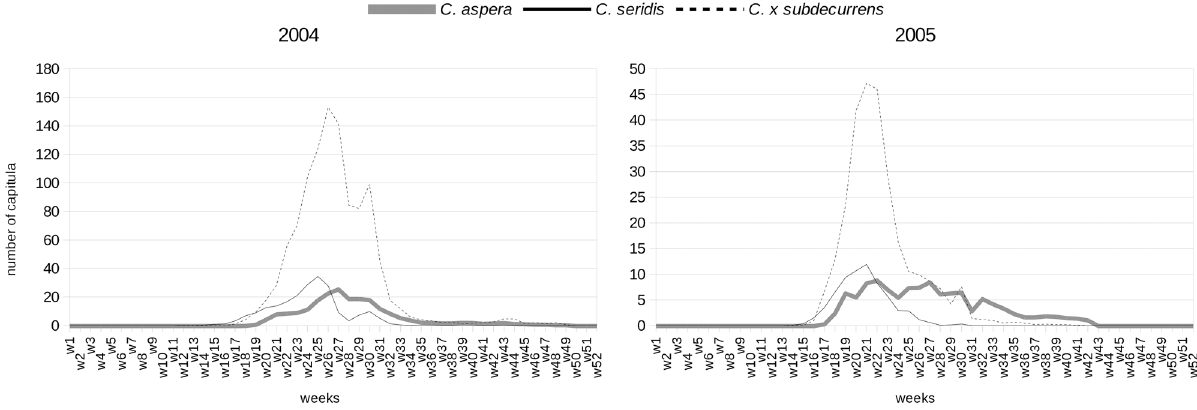
Fig 1. Flowering phenology of the diploid Centaurea aspera , the tetraploid C . seridis , and the triploid hybrid C . × subdecurrens . w1-w52: weeks of field observations; w1: start at January 5th-11th for 2004 and January 3rd-9th for 2005.